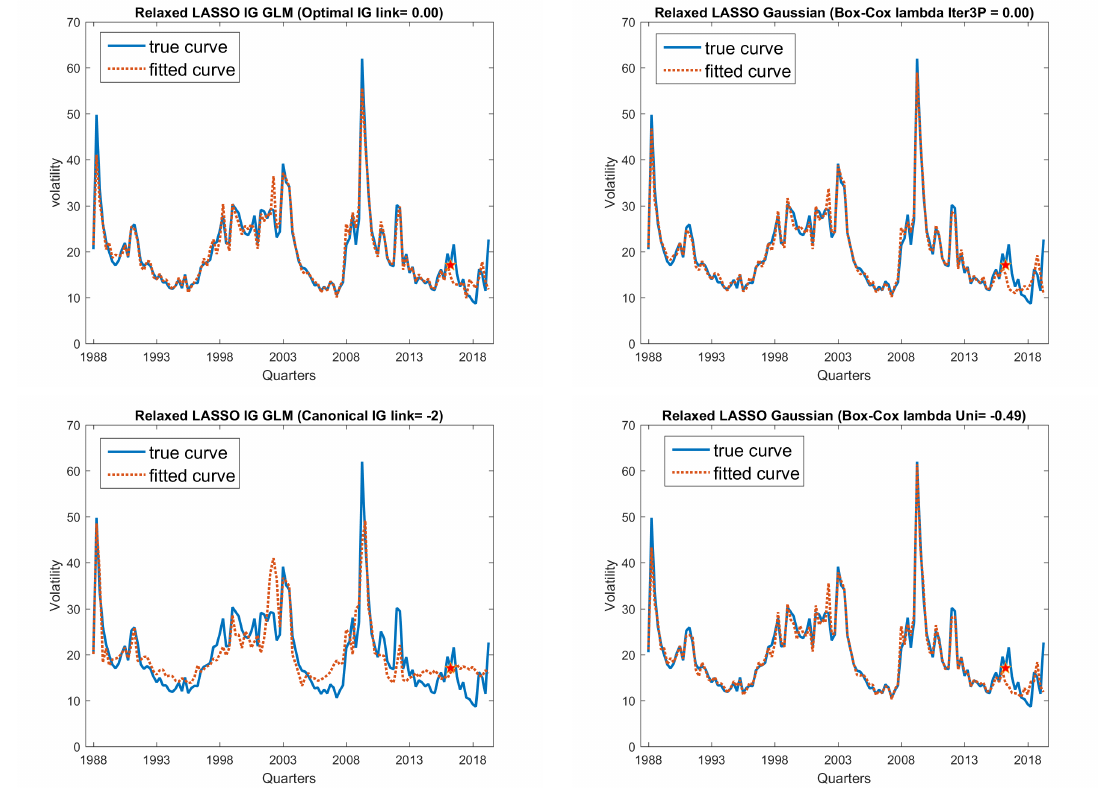
Figure 9. Fitted curve in comparison with true curve: VXO on macro + PC30